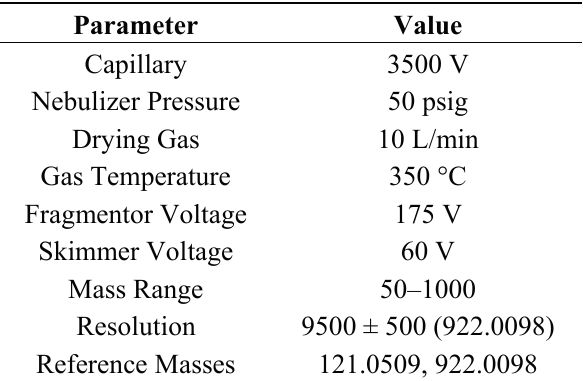
Table 4. TOP-MS operational